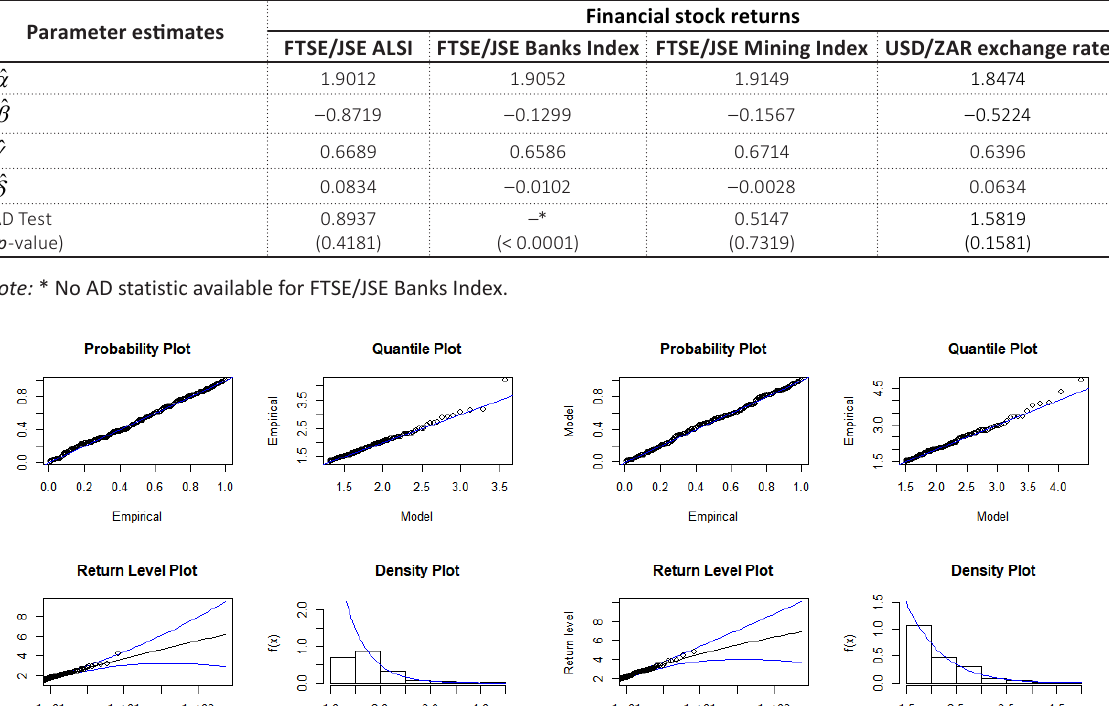
Table 6. ML parameter estimates of the hybrid GARCH-type-SD